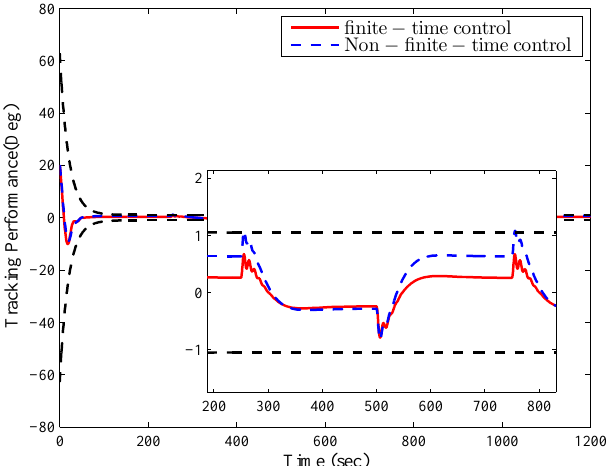
Figure 10. Tacking errors of finite-time and non-finite-time controll